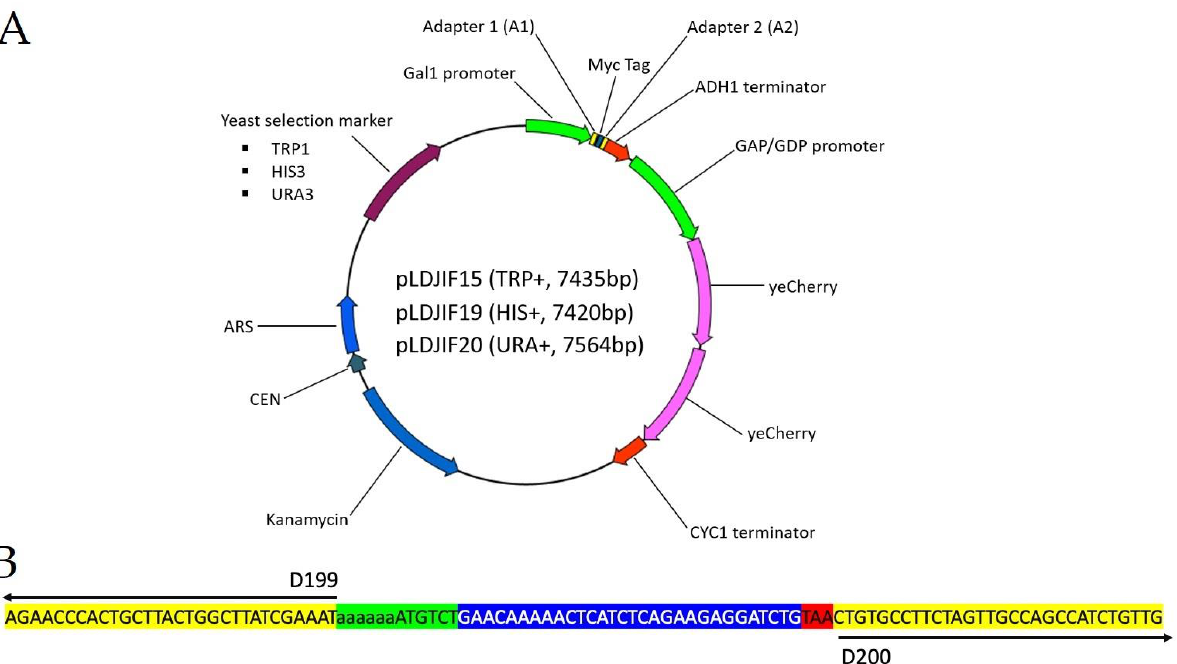
Figure 1. New yeast centromeric plasmids (YCps) for galactose inducible expression. ( A ) A schematic of three yeast centromeric plasmids. Not drawn to scale. See GenBank files in supplementary data for sequences. ( B ) Detailed sequence detail from Adapter 1 and 2. Yellow, left: Adapter 1, right: Adapter 2; Green: Yeast Translational Entry Site; Blue: Myc Tag; Red: Stop codon.